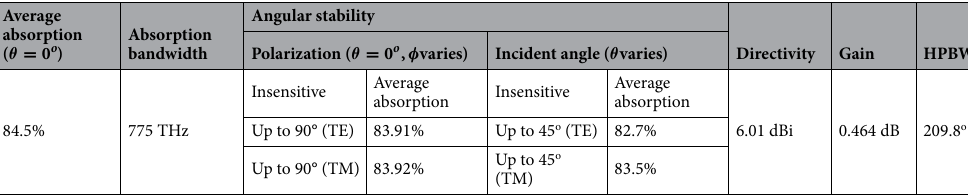
Table 7. The performance parameters of the proposed unit cell